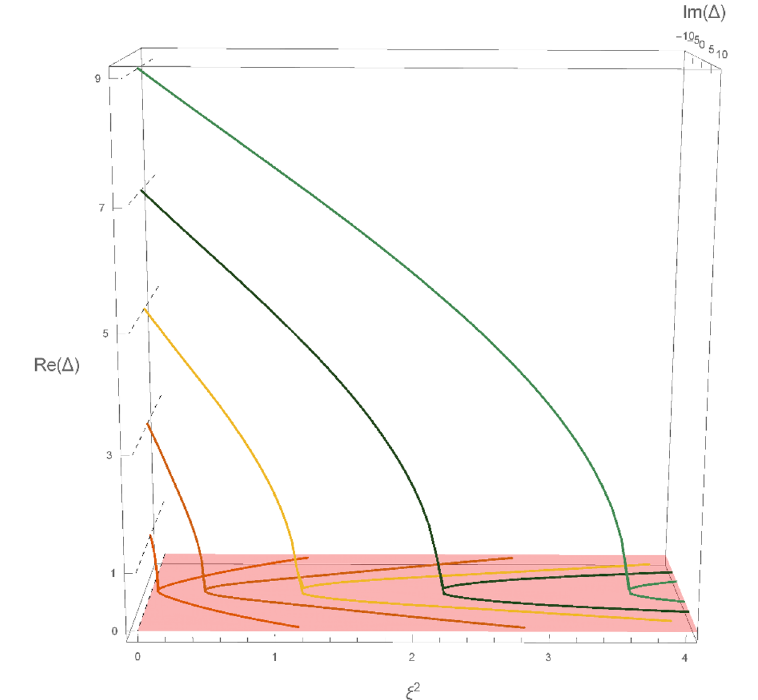
Figure 11 . The (cid:12)rst (cid:12)ve states for J 1 = 1 ; J 2 = 0, S 1 = S 2 = 0, with (cid:18) 1 = 5 = 6 and (cid:18) 2 = 1 = 6. All states reach a branch point where (cid:1) = 0, after which the scaling dimension becomes purely imaginary and scales classically, j (cid:1) j (cid:24) (cid:24) for (cid:24) ! 1 . The strong coupling behaviour will be studied in section